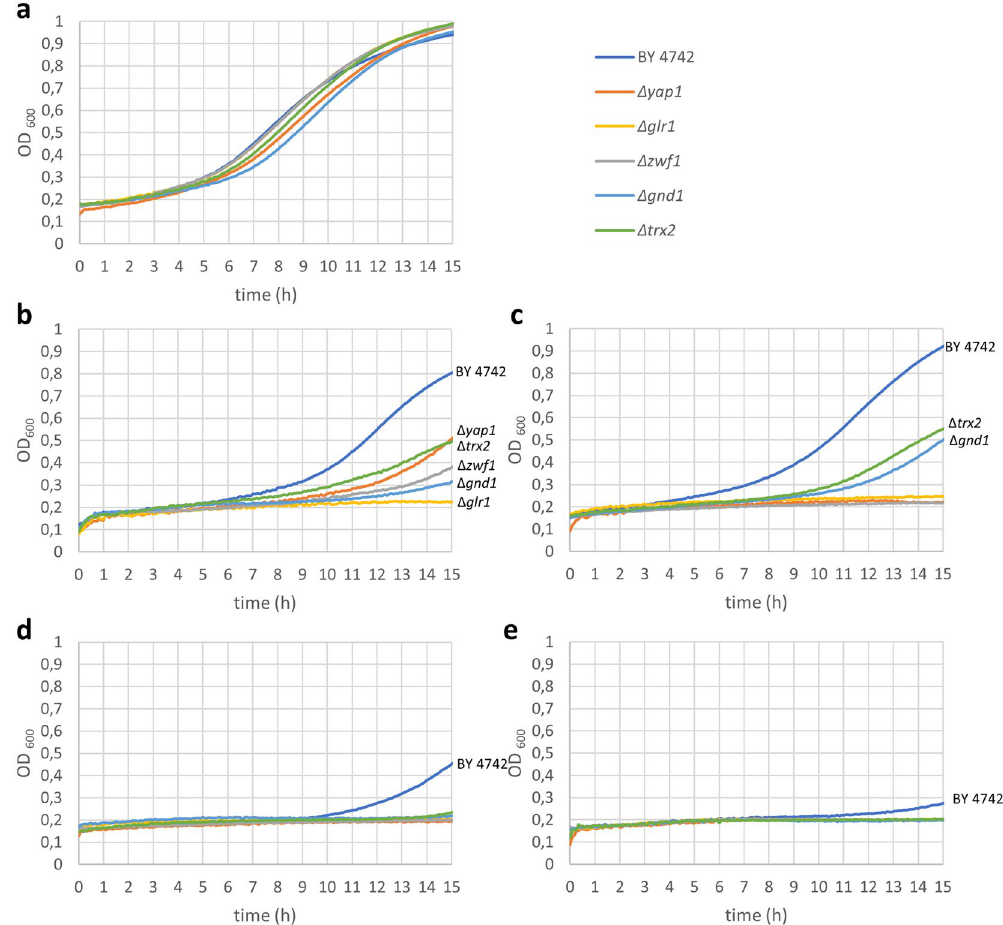
Figure 10. Effects of 50 µ M thiosulfinates on the growth in shake culture of wt BY4742 and Δ yap1 , Δ glr1 , Δ zwf1 , Δ gnd1 , and Δ trx2 mutant yeast cells in CSM. ( a ) CSM alone (control); ( b ) DMTS; ( c ) DETS; ( d ) DATS (allicin); ( e ) DPTS. The experiments were repeated twice with similar